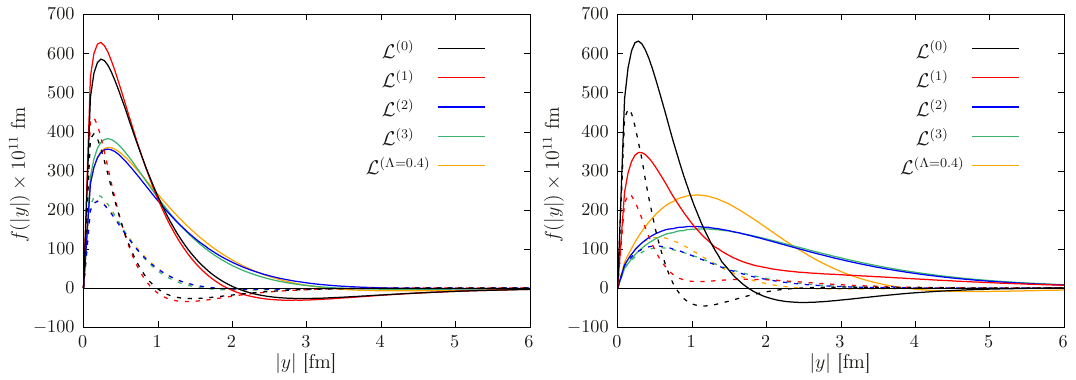
Figure 8 . The integrand with respect to the variable | y | leading to a LbL